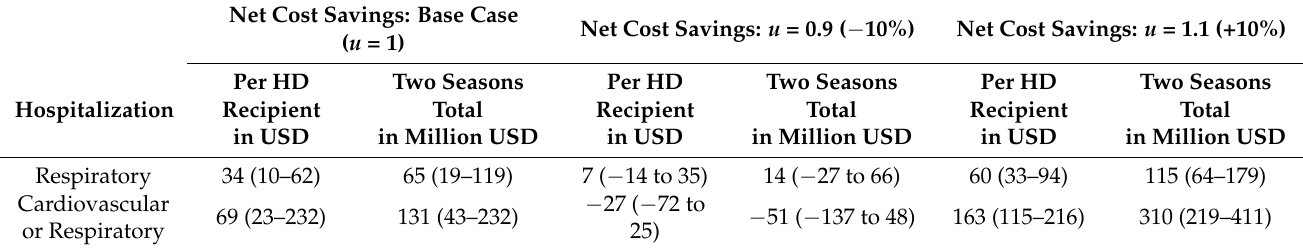
Table 4. Sensitivity analysis net cost savings: PERR bias parameter +/ − 10% of base case ( u =